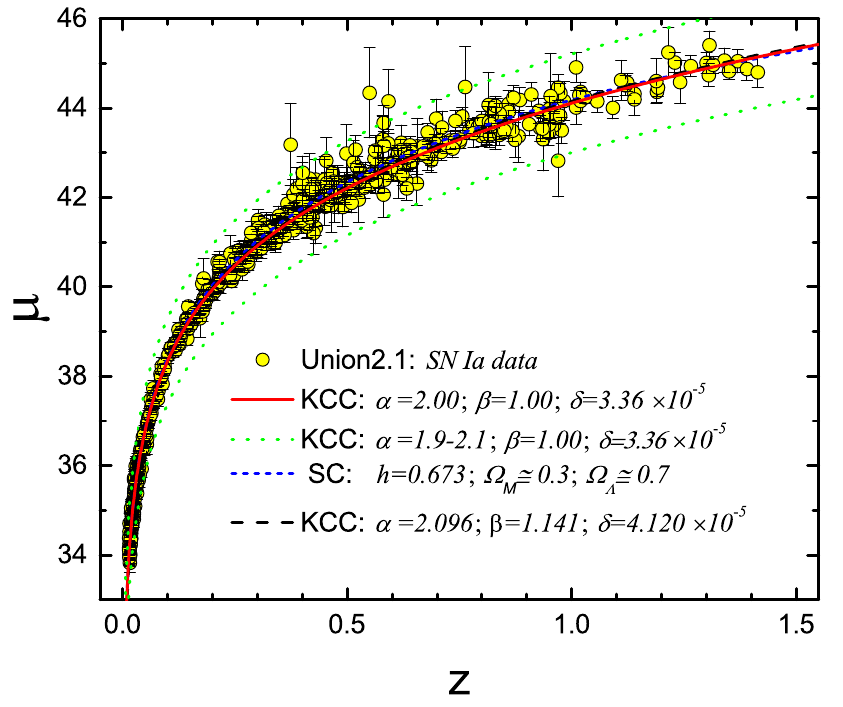
Figure 1. Data from Union 2.1 SNIa set [35] are fitted with Equation (25). Our KCC fits (red-solid for fixed α and β ; black long-dashed for variable α and β ) show very good statistical quality ( R 2 = 0 . 996 ) and are very close to the standard cosmology prediction (SC, blue short-dashed). Also shown (dotted-green curves) is the range of our KCC fitting curves for a variable α = 1 . 9 − 2 . 1